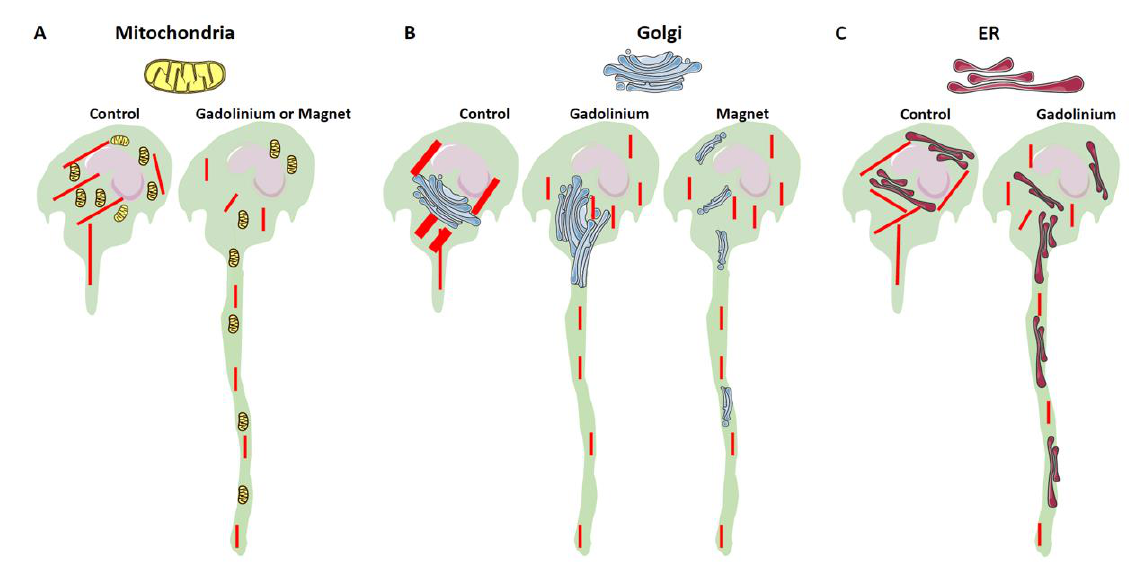
Figure 11. Diagram summarizing the effects of Dotarem and the magnetic field gradient on the distribution of organelles. ( A – C ) Distribution of mitochondria, Golgi, and ER in the control and treated cells. All these organelles were anchored at their proper subcellular locations by the actin filaments (depicted in red). Dotarem (gadolinium) treatment and magnetic field gradient exposure disrupted the actin cytoskeleton and changed the distribution of organelles. ( A ) Dotarem treatment and magnetic field gradient exposure had very similar effects on the distribution of mitochondria. ( B ) Dotarem treatment or magnetic field gradient exposure changed the Golgi distribution, but the effects were different. While Dotarem caused the extension of the Golgi marker-positive area, exposure to the magnetic field gradient caused, as described by Wosik et al. (2018), the dispersion of the Golgi complex. ( C ) Dotarem treatment caused a redistribution of the ER toward the cell extensions. There are no data on the effect of the magnetic field on ER distribution in the studied cells.